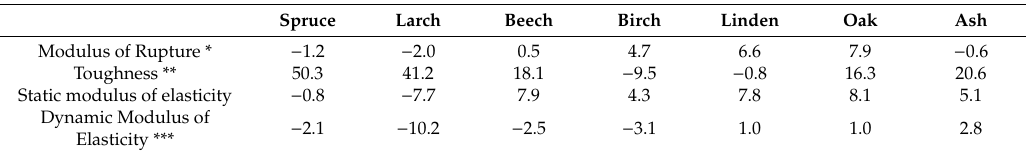
Table 8. Percentage comparison of a specific quantity (property) in anatomical directions (radial / tangential) for individual specific wood